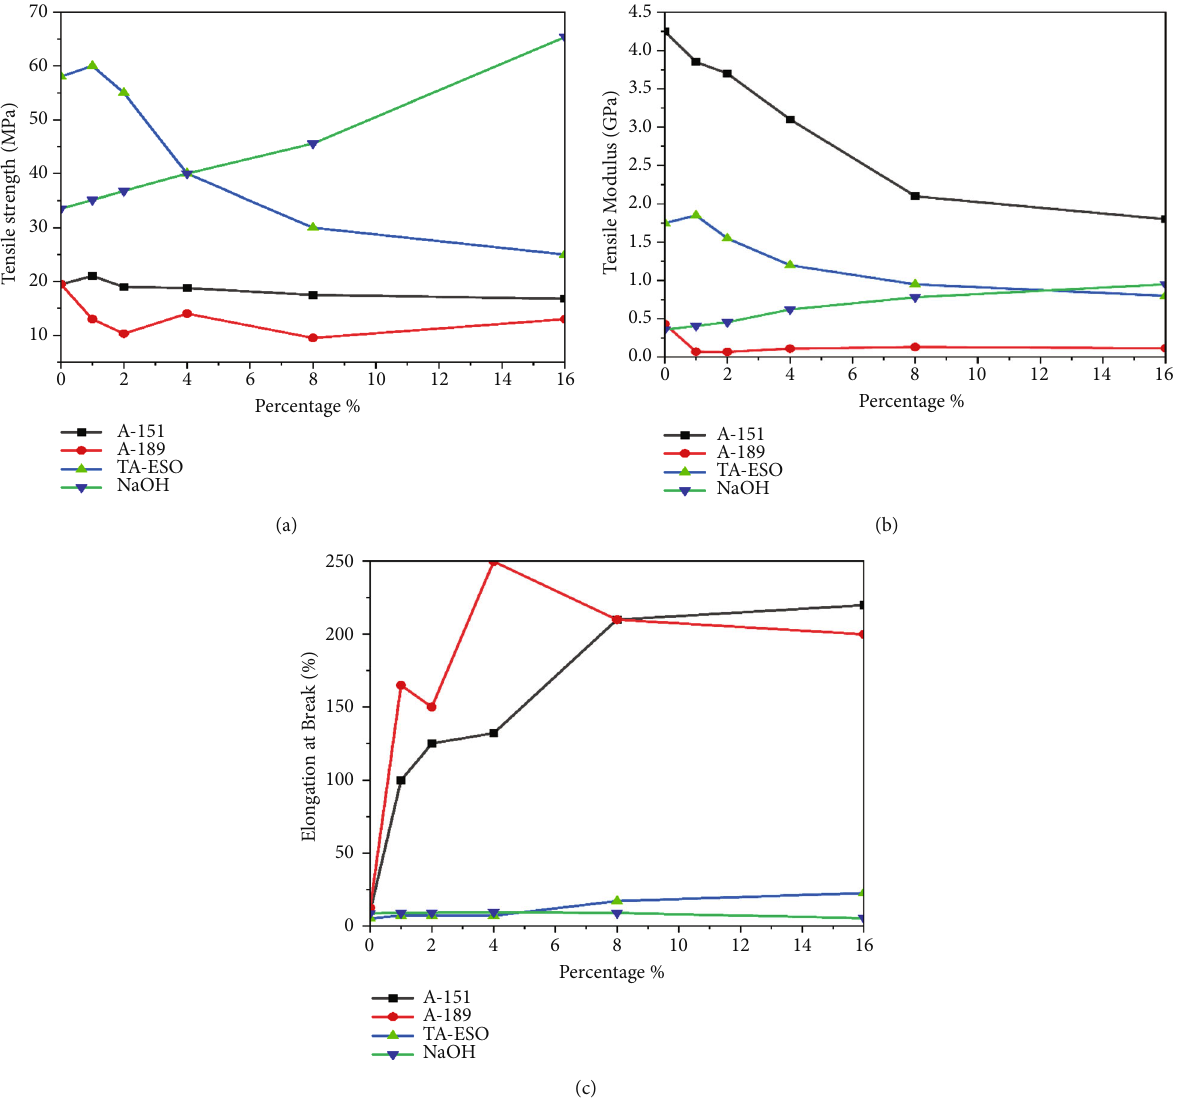
Figure 6: Mechanical properties of PLA composites pretreated at di ff erent concentrations: (a) tensile strength, (b) tensile modulus, and (c) elongation at break [49, 53, 56,